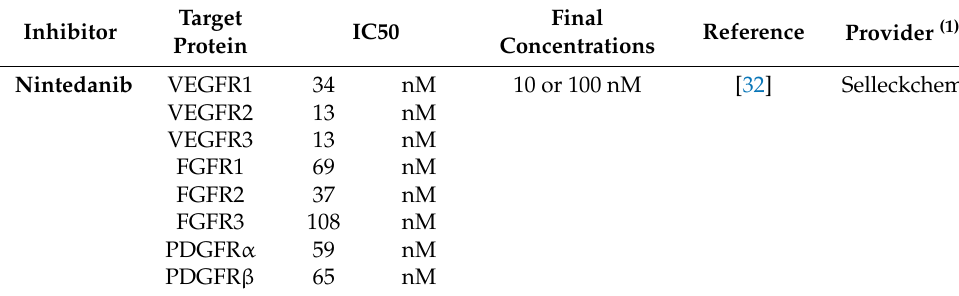
Table 1. Characteristics of